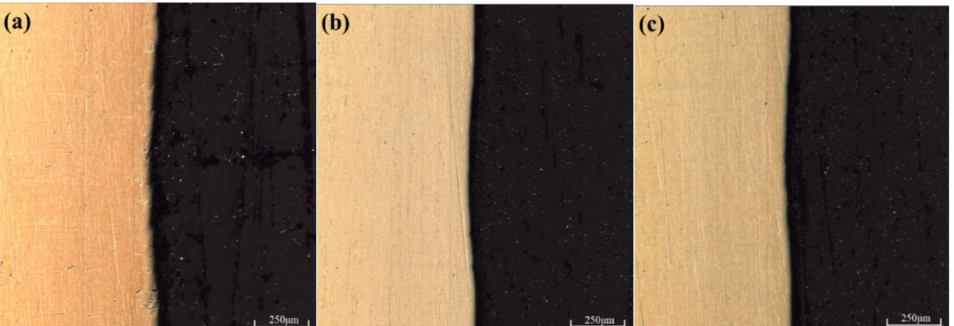
Figure 6. Cross-sectional morphology of MAO layers on TC4 alloys with different particle